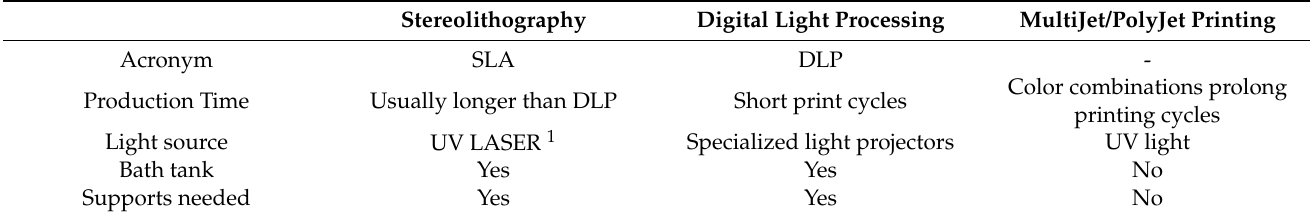
Table 1. Additive manufacturing methods for